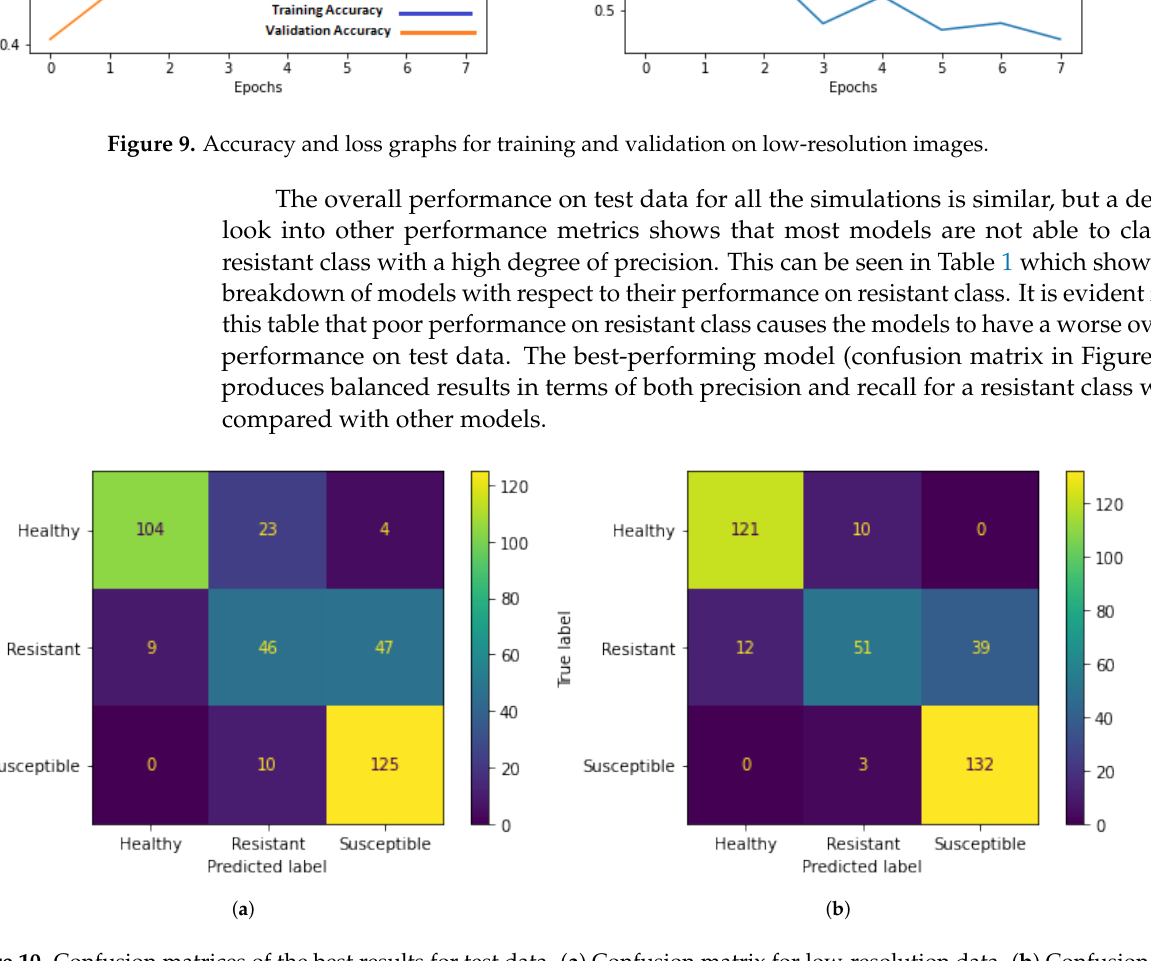
Figure 10. Confusion matrices of the best results for test data. ( a ) Confusion matrix for low-resolution data. ( b ) Confusion matrix for high-resolution